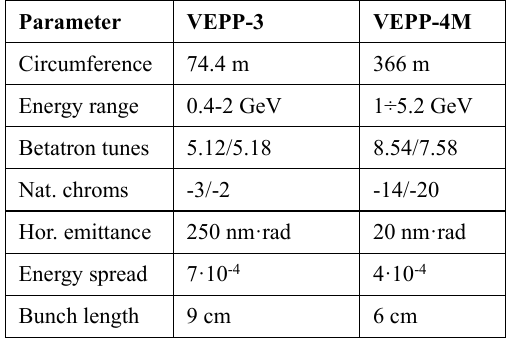
Fig. 2 . VEPP-4 accelerator complex layout. Table 2 . Parameters of VEPP-3 at 2 GeV and VEPP-4M at 1.8